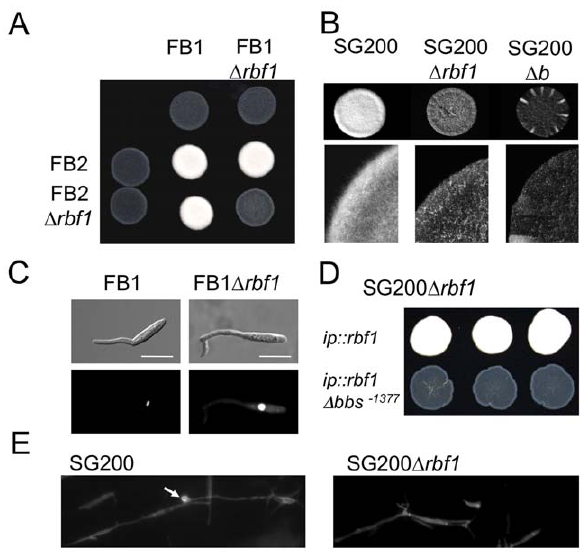
Figure 3. Rbf1 is required for b -dependent filament formation. ( A ) Mixtures of wild-type U. maydis strains FB1 ( a1b1 ) and FB2 ( a2b2 ) and of the respective D rbf1 strains and ( B ) of the solopathogenic strain SG200 ( a1mfa2 bE1bW2 ) and its D rbf1 and D b derivatives were spotted on PD charcoal plates to induce filament formation. Filamentation is drastically reduced in all D rbf1 -strains. ( C ) FB1 and FB1 D rbf1 cells grown in CM medium supplemented with 1% glucose (CMD) (OD 600 =0.2) were treated with synthetic a2 pheromone (2.5 m g/ml) for six hours; nuclei were visualized by DAPI staining. Rbf1 is not required for the pheromone-induced conjugation tube formation and cell cycle arrest. Scale bar=10 m m. ( D ) Transformants of SG200 D rbf1 obtained by integration into the ip -locus of (1) the rbf1 open reading frame with the wild-type 3 kb 5 9 -upstream region ( ip::rbf1 ), or (2) the rbf1 open reading frame with a 3 kb 5 9 -fragment harbouring a deletion of the bbs - motif at position 2 1377 ( ip::rbf1 D bbs 2 1377 ). Shown are three indepen- dent transformants each spotted on PD charcoal plates. While the rbf1 gene with the wt-promoter fragment is capable to complement the rbf1 deletion, restoring filamentous growth, the deletion of bbs 2 1377 renders the transforming fragment inactive, indicating that binding of the bE1/ bW2-heterodimer to bbs 2 1377 is required for rbf1 expression. ( E ) Calcofluor staining of fungal hyphae on the leaf surface. 16 hours post inoculation, both U. maydis SG200 and SG200 D rbf1 have formed filaments; no appressoria were found in SG200 D rbf1 . The arrow marks the appressorium.